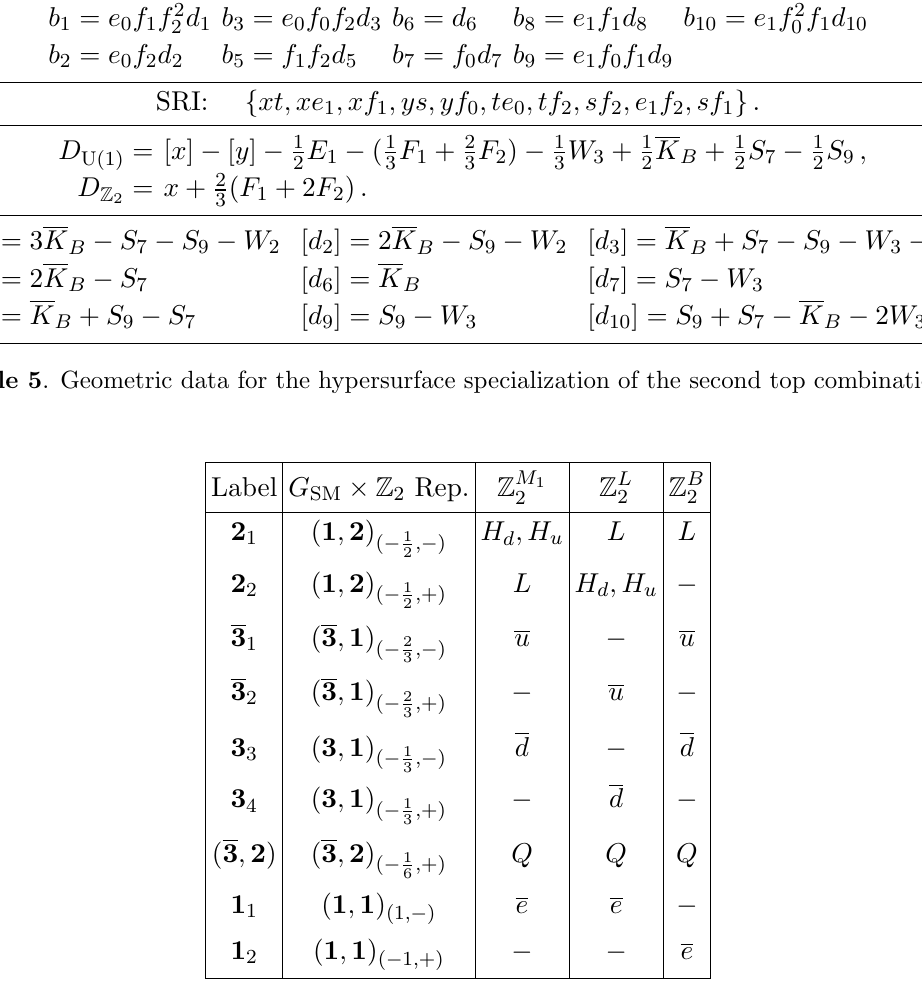
Table 6 . Matter curves and their charges as given for the second top combination. MSSM (cid:12)eld iden- ti(cid:12)cations under various Z 2 symmetries are given in the last three columns. For each identi(cid:12)cation we assign the chirality three to MSSM (cid:12)elds whereas states marked with a \ (cid:0) " must be